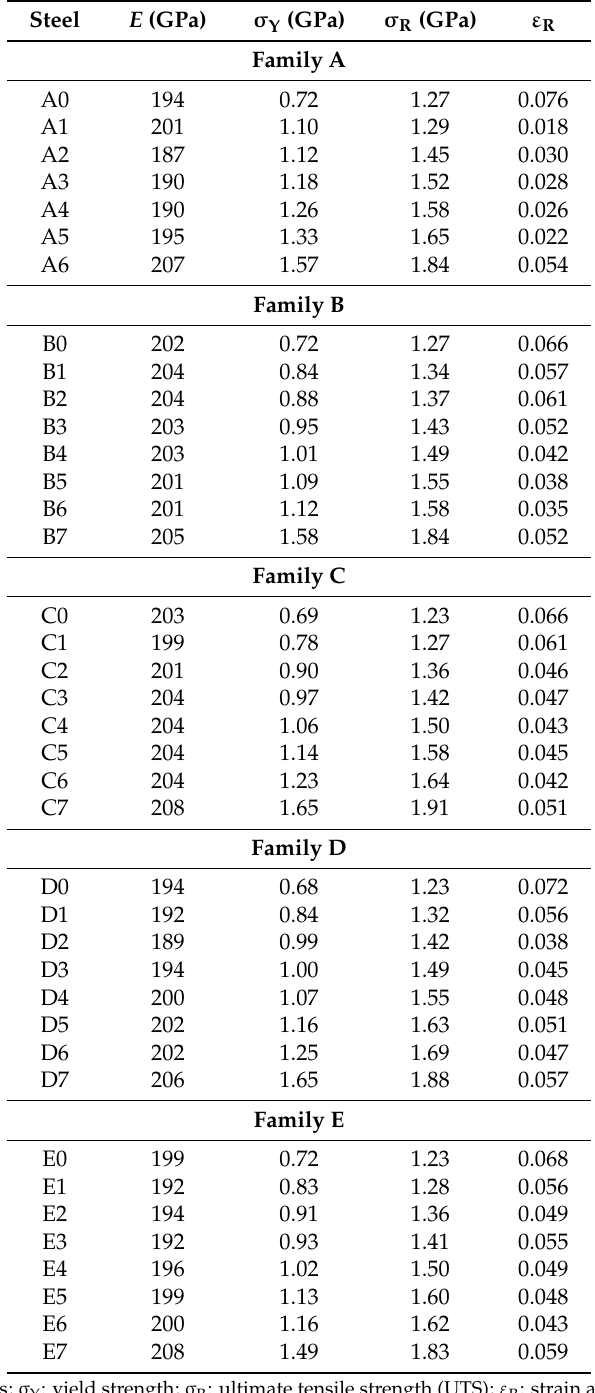
Table 4. Main mechanical properties for each drawing step of the considered